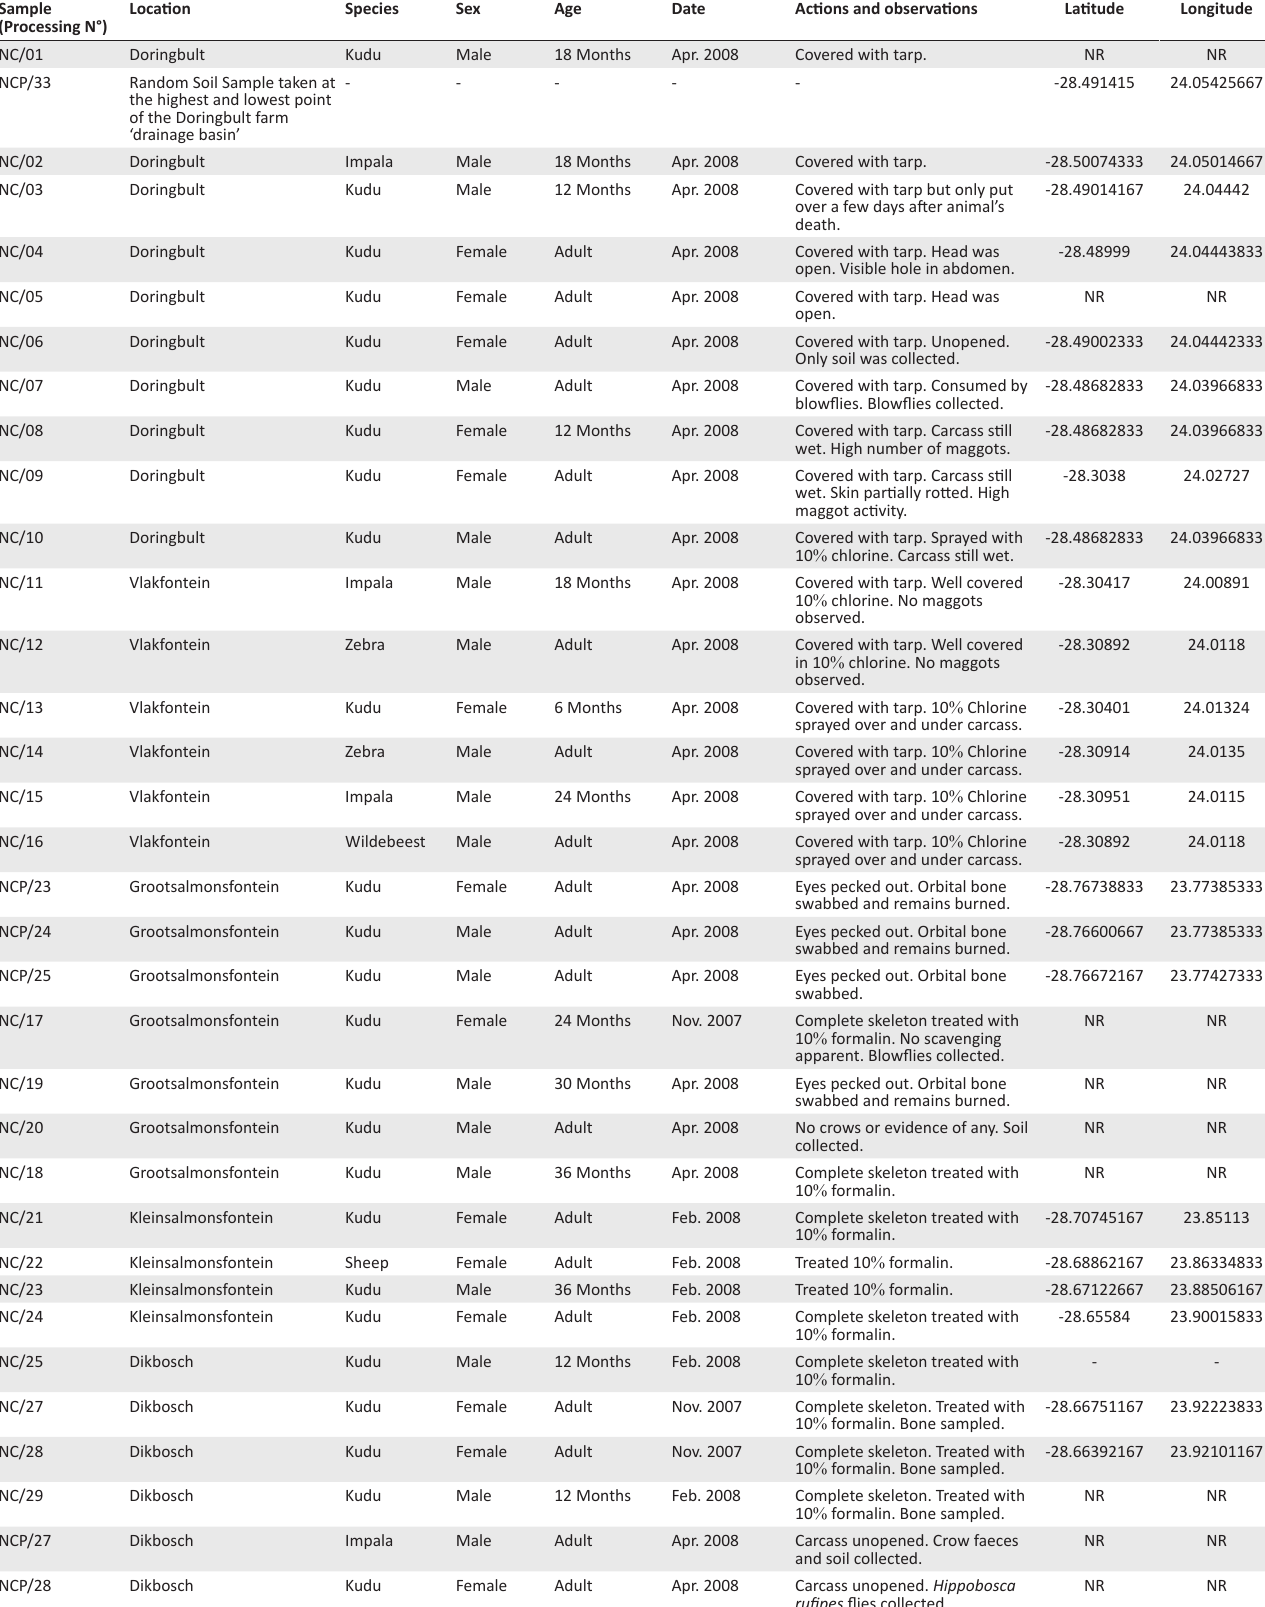
TABLE 1: Anthrax-positive carcasses (based on Giemsa stained blood smears) and environmental samples collected from farms along the Ghaap Plateau in the Northern Cape province, South Africa, during outbreaks in 2007–2008 indicating control measures implemented by farm owners and State Veterinary Services. Sample (Processing N°)